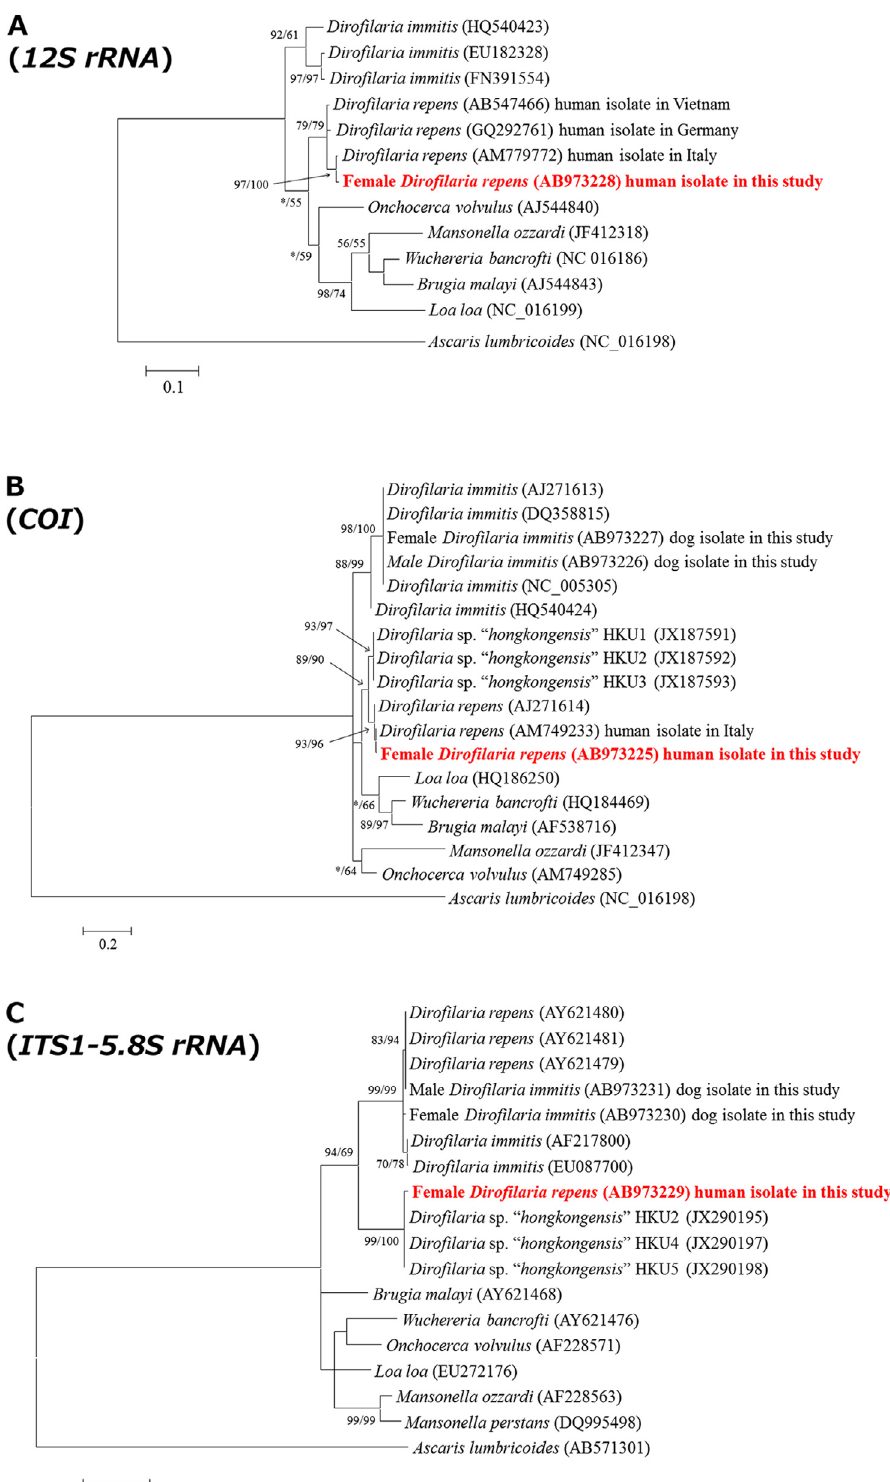
Figure 2. Phylogenetic relationships by maximum likelihood (ML) analysis among sequences of mitochondrial 12S ribosomal RNA (A), mitochondrial cytochrome c oxidase subunit 1 (B) genes, and the internal transcribed spacer 1-5.8S ribosomal RNA region (C). The ML tree was derived from a general time-reversible model using a discrete gamma distribution (+G) with five rate categories and invariant sites (+I). Significant bootstrap support for the ML analysis with 1000 replicates and Bayesian analysis (BI) are shown above the nodes in the order ML/BI. An asterisk indicates <50% support for a node. The scale bar represents the genetic distance in single nucleotide substitutions. GenBank accession numbers are given within